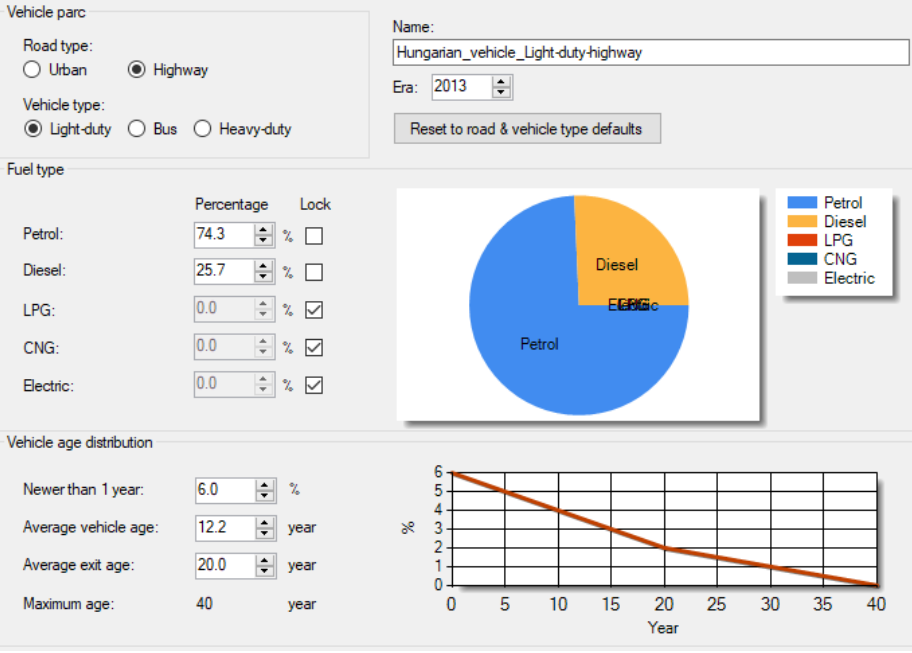
Figure 4. Parameters for